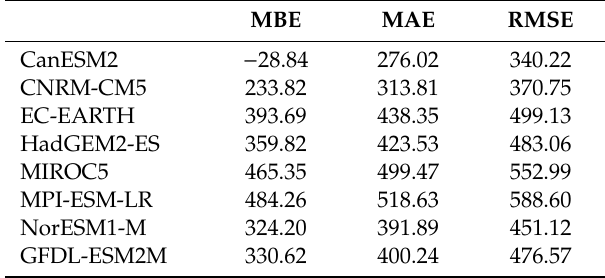
Figure 4. Compared evolution of the total annual observed and simulated rainfall. Table 7. Results of statistical criteria for annual rainfall accumulation.